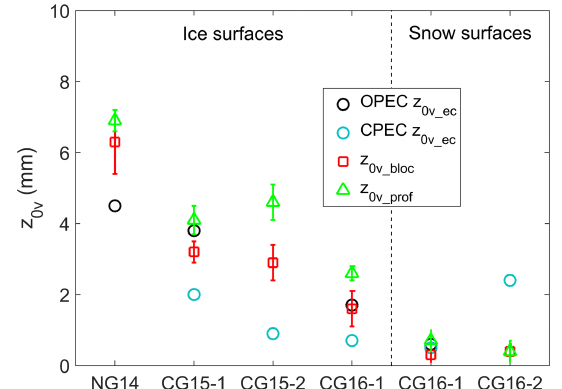
Figure 11. Comparison of geometric mean OPEC and CPEC mo- mentum roughness length observations with z 0v_bloc and z 0v_prof estimates from the remote methods. Values are separated into ice and snow surface types. Error bars represent the calculated uncer- tainty in the z 0v_bloc method, and σ of the z 0v_prof values for a 101 × 101m upwind patch. The standard deviation of each of the mean z 0v_ec values (see Table 4) extends beyond the y -axis